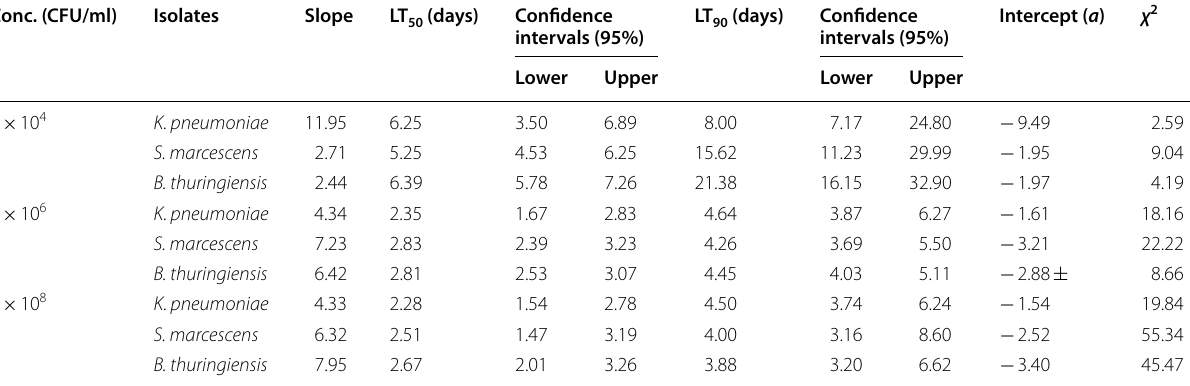
Overlapping confidence intervals mean insignificant